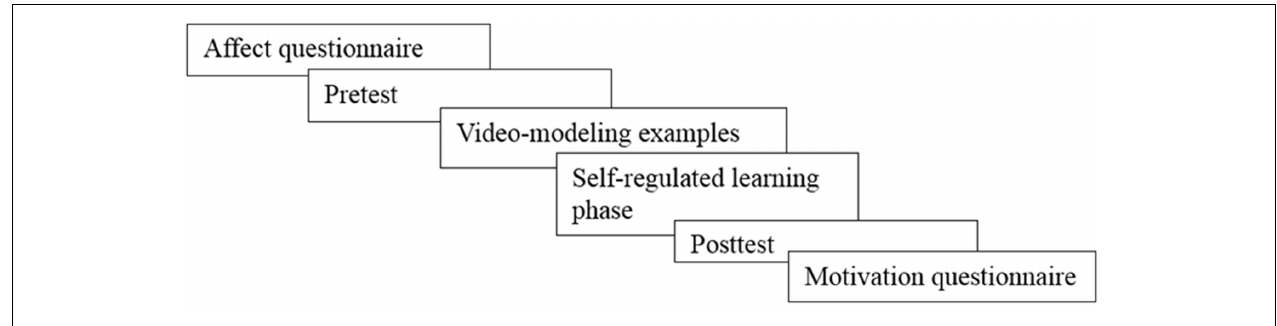
FIGURE 2 | Procedure of the